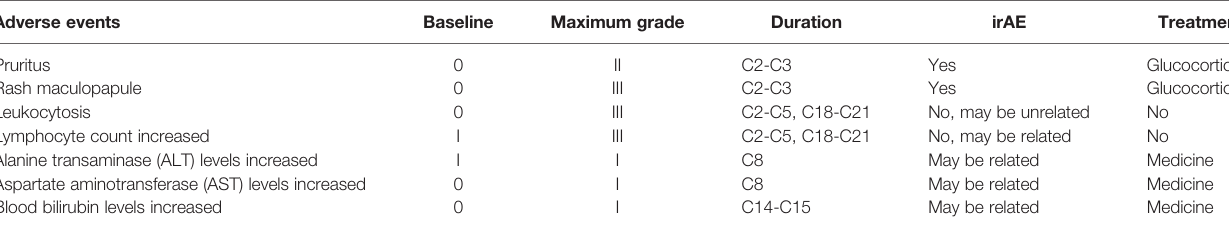
The fi rst screening indicators after the clinical trial as the baseline; CTCAE, Common Terminology Criteria for Adverse Events; C, cycle; irAE, immune-related adverse events.